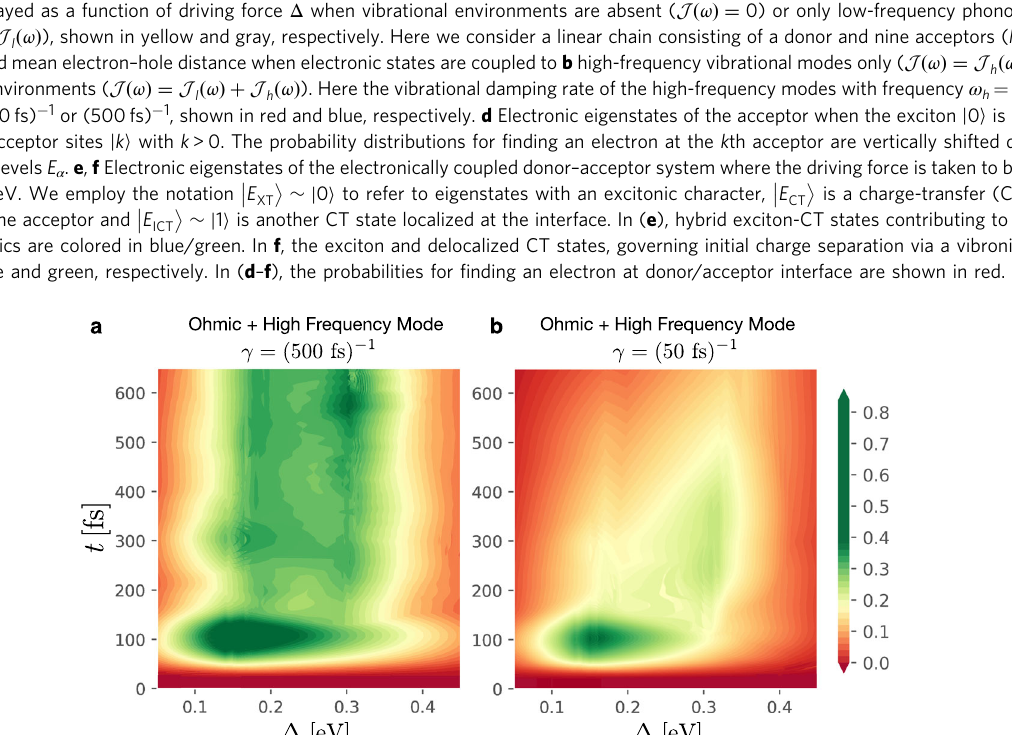
Fig. 3 Long-range charge separation dynamics. a , b Total probability for separating an electron – hole pair more than four molecular units, ∑ 9 k as a function of time t and driving force Δ . The colorbar quanti fi es the sum of probabilities ∑ 9 k successful charge separation. Here a linear chain consisting of N = 10 sites is considered where electronic states are coupled to total vibrational environments ( J ð ω Þ ¼ J l ð ω Þ þ J h ð ω Þ ). The damping rate of the high-frequency vibrational modes with ω h = 1200cm − 1 is taken to be ( a ) γ = (500fs) − 1 or ( b ) γ = (50fs) − 1 V /2 = 0.15 eV > J 1,2 ≈ 0.06 eV). The other higher energy CT eigenstates are signi fi cantly delocalized in the acceptor domain with smaller populations jh 1 j E ð CT Þ α ij 2 at the interface for higher energies E ð CT Þ α , as highlighted in red.